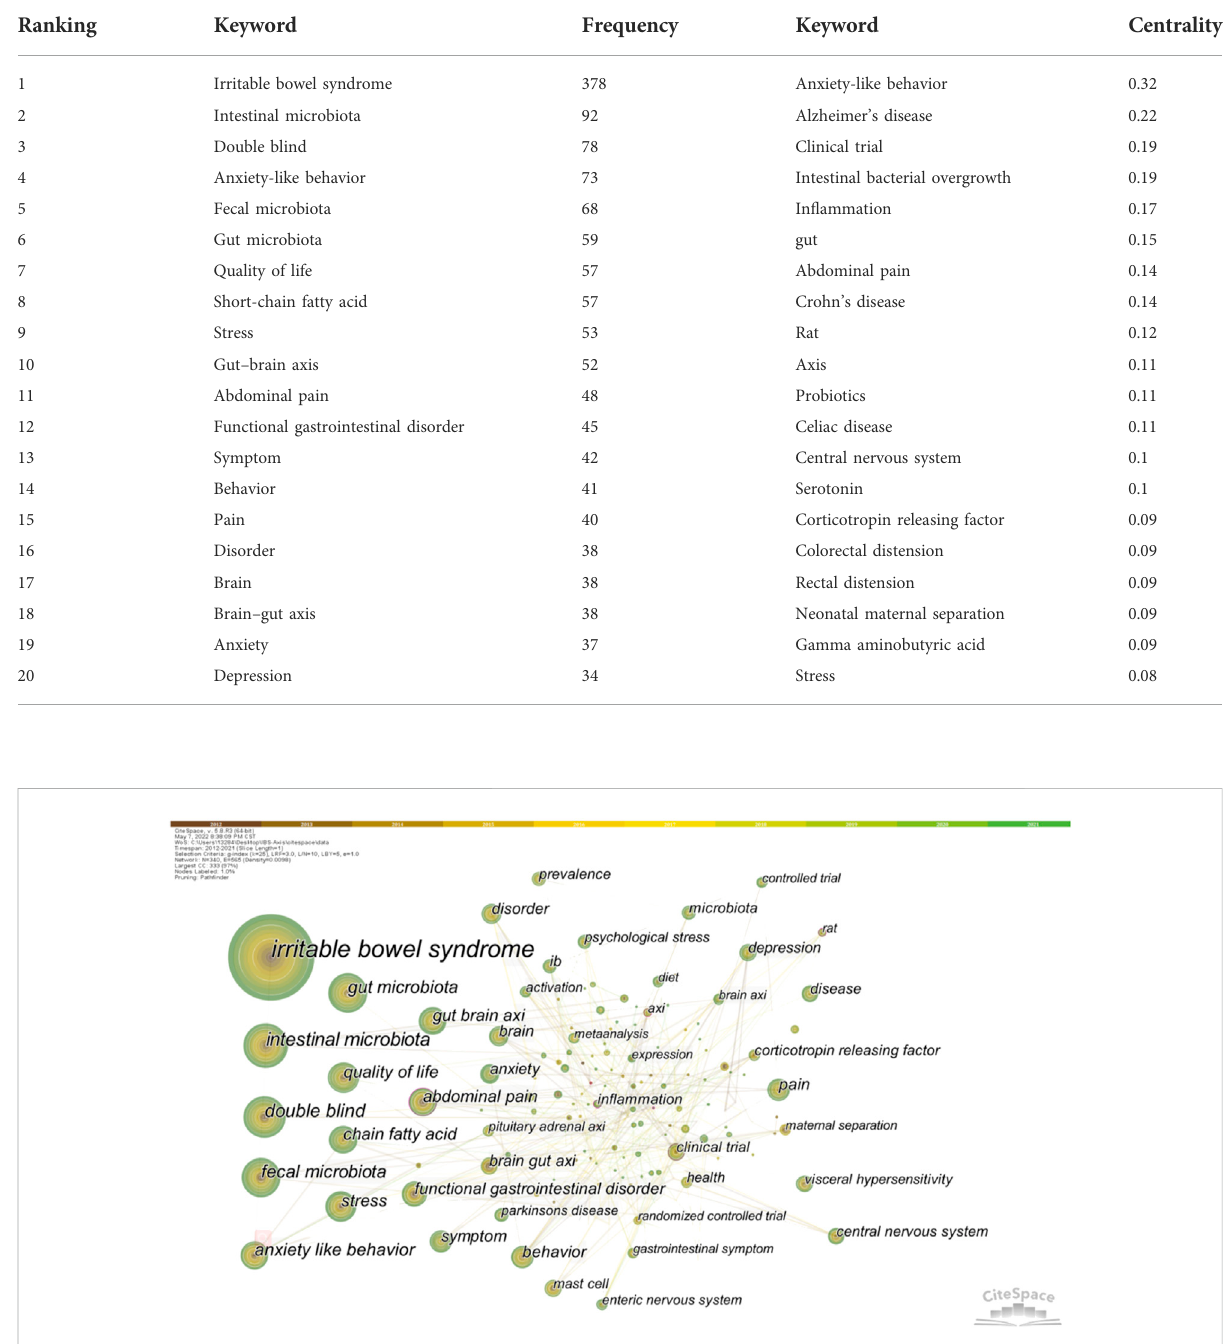
TABLE 3 Top 20 keywords in terms of frequency and centrality.